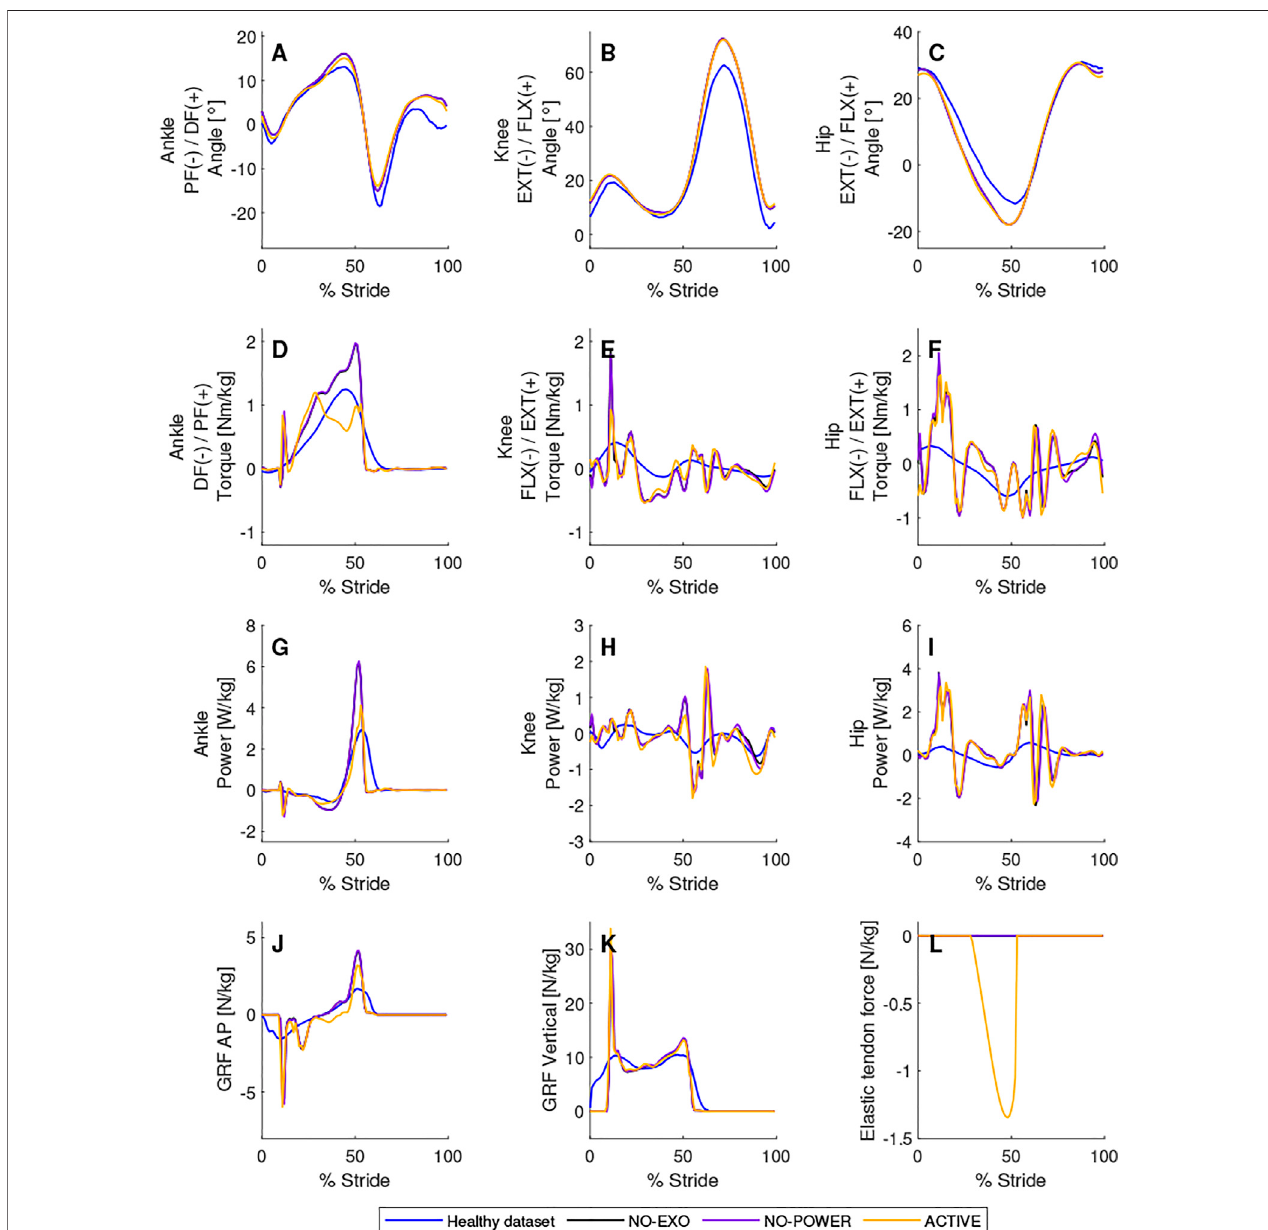
FIGURE 4 | Comparison between a dataset of healthy people and modeled walking with an active, unpowered and without AN-EXTRA-Push exoskeleton. Joint angles (A – C) , biological torques (D – F) and powers (G – I) are shown for the right leg on which AN-EXTRA-Push is worn. In (J) and (K) , antero-posterior and vertical ground reaction forces are shown. In (L) , force in the elastic tendon is shown. Conditions are abbreviated and color coded as follows: healthy subjects average from a public database (Healthy dataset) (blue), without exoskeleton (NO-EXO) (black), unpowered exoskeleton (NO-POWER) (purple), and a powered exoskeleton conditionwithparameters:brakeengagementtimingof29%ofstride,brakedisengagementtimingof53%ofstrideandelastictendonstiffnessof4.85 N/m/kg(ACTIVE) (yellow).